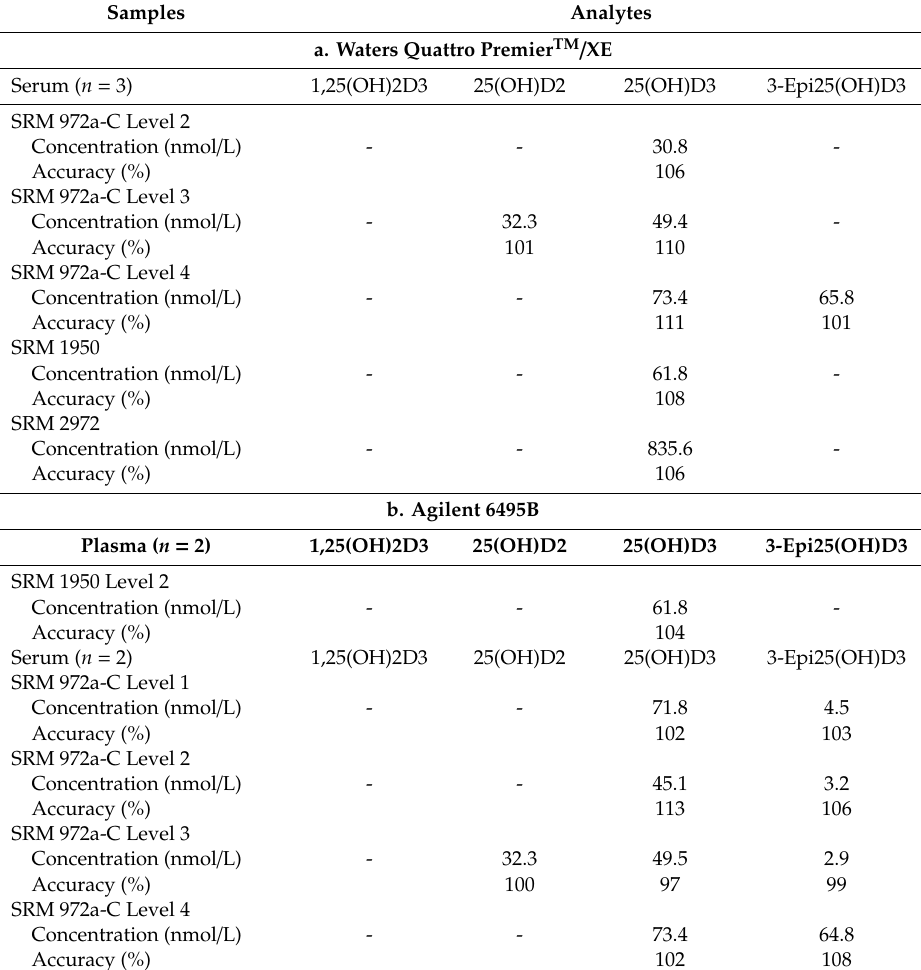
Table A2. Accuracy for the analysis of 25(OH)D2, 25(OH)D3, and 3-Epi25(OH)D3 in plasma and serum